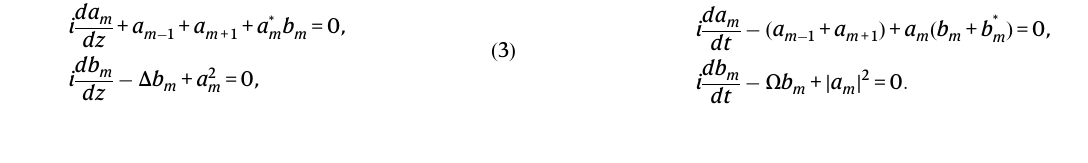
Fig. 2 | Thermalization of light in nonlinear waveguide arrays with different nonlinearities. Linear and nonlinear couplings in three optical lattices when acted upon by three different nonlinearities: a a Kerr nonlinearity, c cascade χ (2) process, and e optomechanical nonlinearities, asdescribed by Eqs. (1),(3),and (4), respectively. Numerical simulations provide the modal occupancies after therma- lization in all these three scenarios, in good agreement with the predicted Rayleigh – Jeans (RJ) distributions (black lines), as shown in b , d , and f . The insets